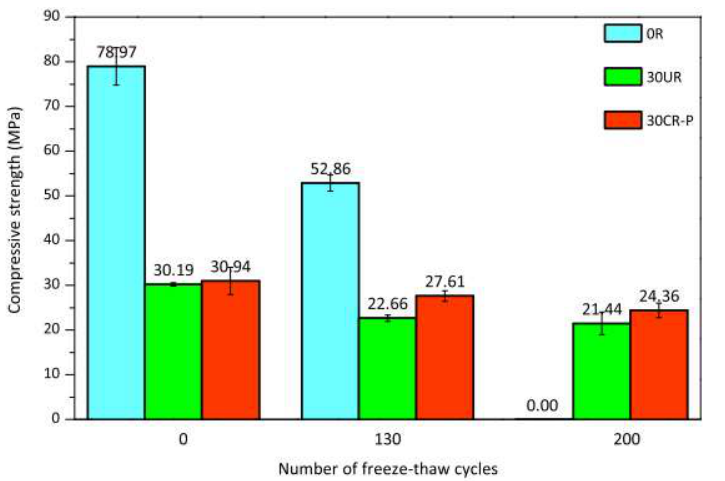
Figure 14. Variation diagram of compressive strength of samples with the increase in freeze–thaw cycles [10].